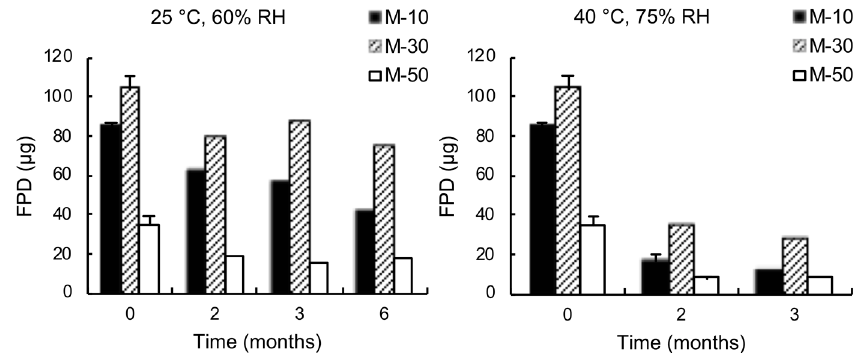
Figure 2. FPD of salbutamol sulphate from ternary mixtures containing 10% w / w (M-10), 30% w / w (M-30), and 50% w / w (M-50) of micronized lactose stored at 25 °C, 60% RH (left) and 40 °C, 75% RH (right). The bars represent the standard deviation ( n = 5).